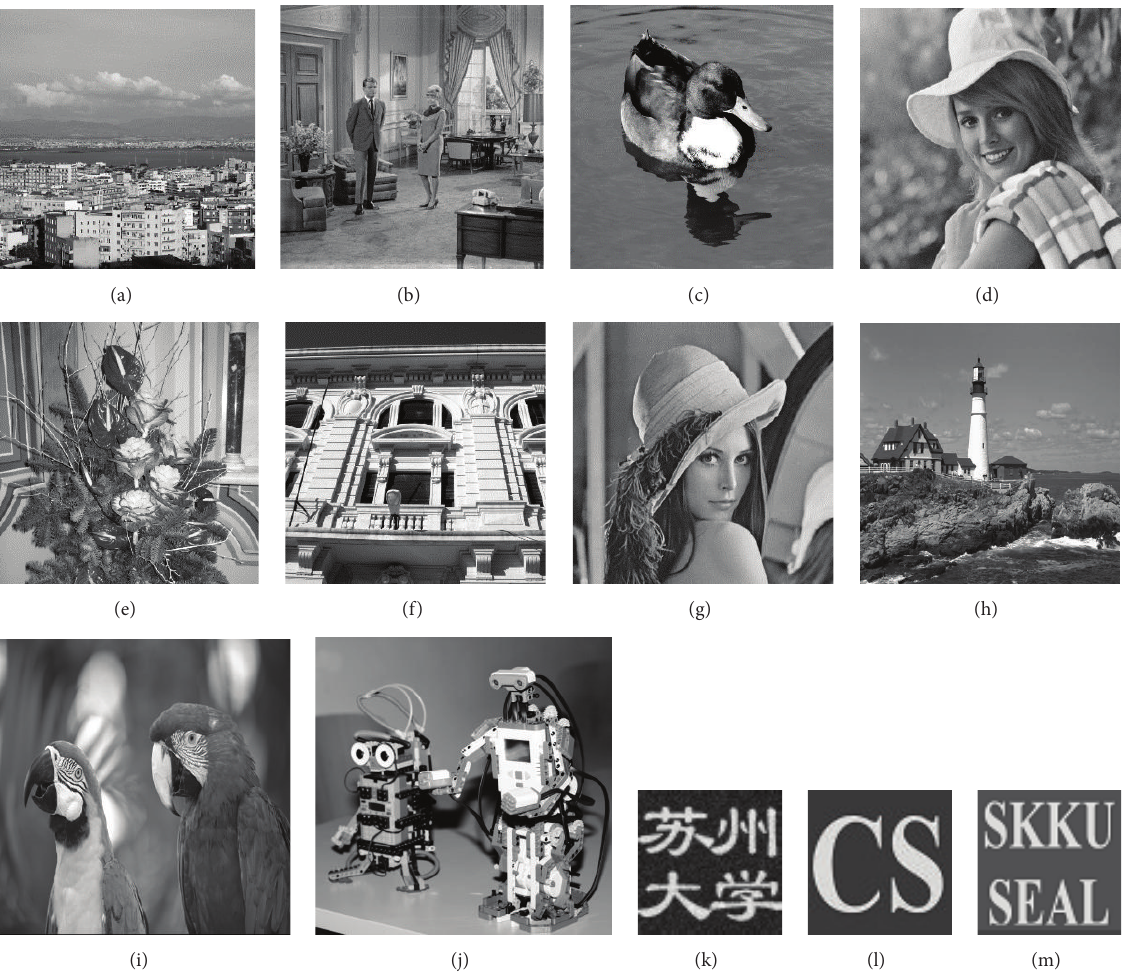
Figure 6: (a)–(j) Host images City, Duck, Elaine, Flowers, House, Lena, Lighthouse, Parrots, and Robots, respectively; (k)–(m) watermark images WM1, WM2, and WM3.